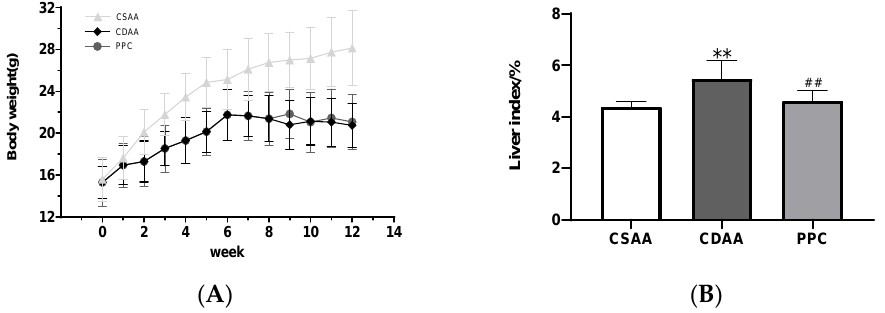
Figure 1. Body weights of mice over 12 weeks ( A ) and the liver index (liver wet weight/body weight ratio) at the end of week 12 ( B ), ** p < 0.01 compared with the negative control (CSAA diet) group; ## p < 0.01 compared with the disease model (CDAA diet) group.